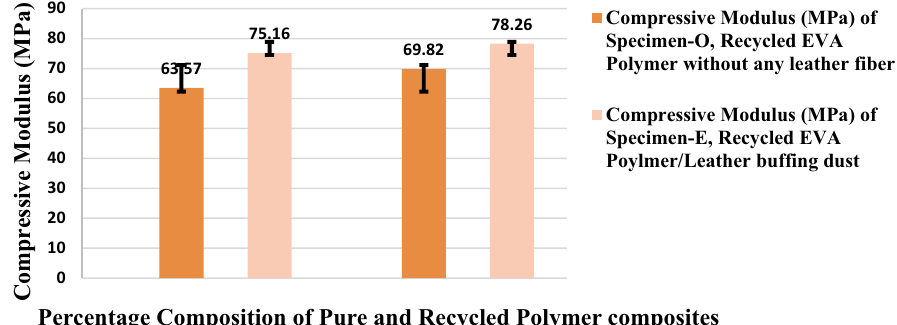
Figure 34: Comparison of compression modulus ( MPa ) of recycled EVA polymer composites with or without leather bu ffi ng